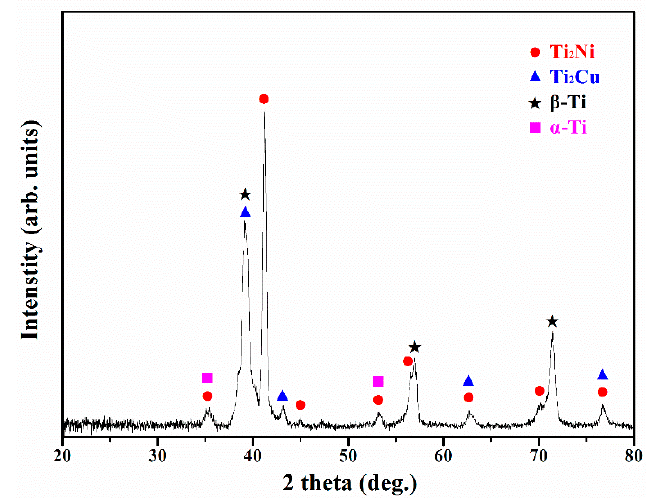
Figure 5. XRD pattern of B3 sample.